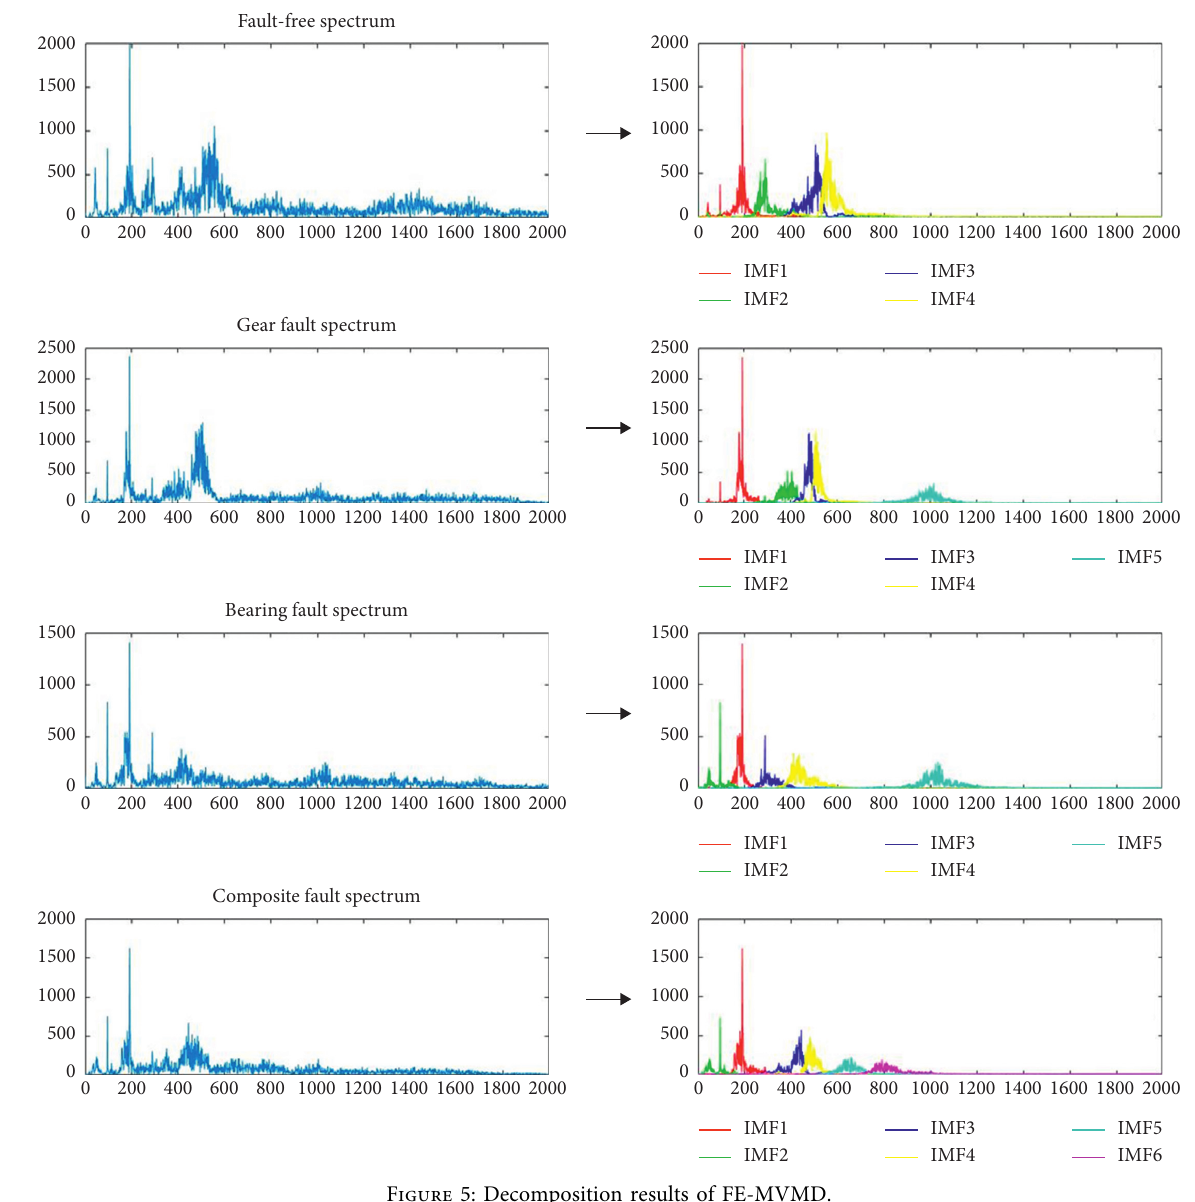
Figure 5: Decomposition results of